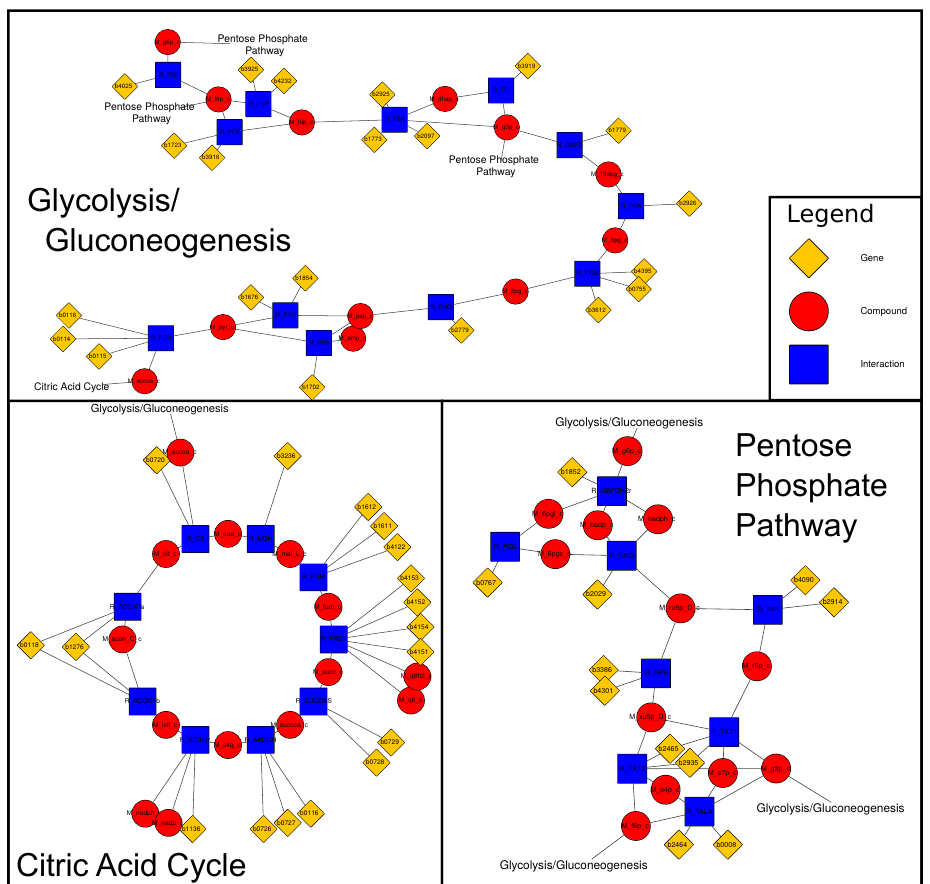
Figure 3. Connected subnetworks for glycolysis/gluconeogenesis, citric acid cycle and the pentose phosphate pathway. The pathways are linked to each other by the linkers (names of the other path- ways). Layouts were generated automatically with Cytoscape layout algorithms and scaled/rotated to fit this figure. Gene nodes were added to the network based on the SBML note fields using IDARE2’s SBML annotation tool. Abundant metabolites like water and phosphate along with co- factors like ATP and Coenzyme-A were set to be removed from the network, while NADPH was set not to extend to other